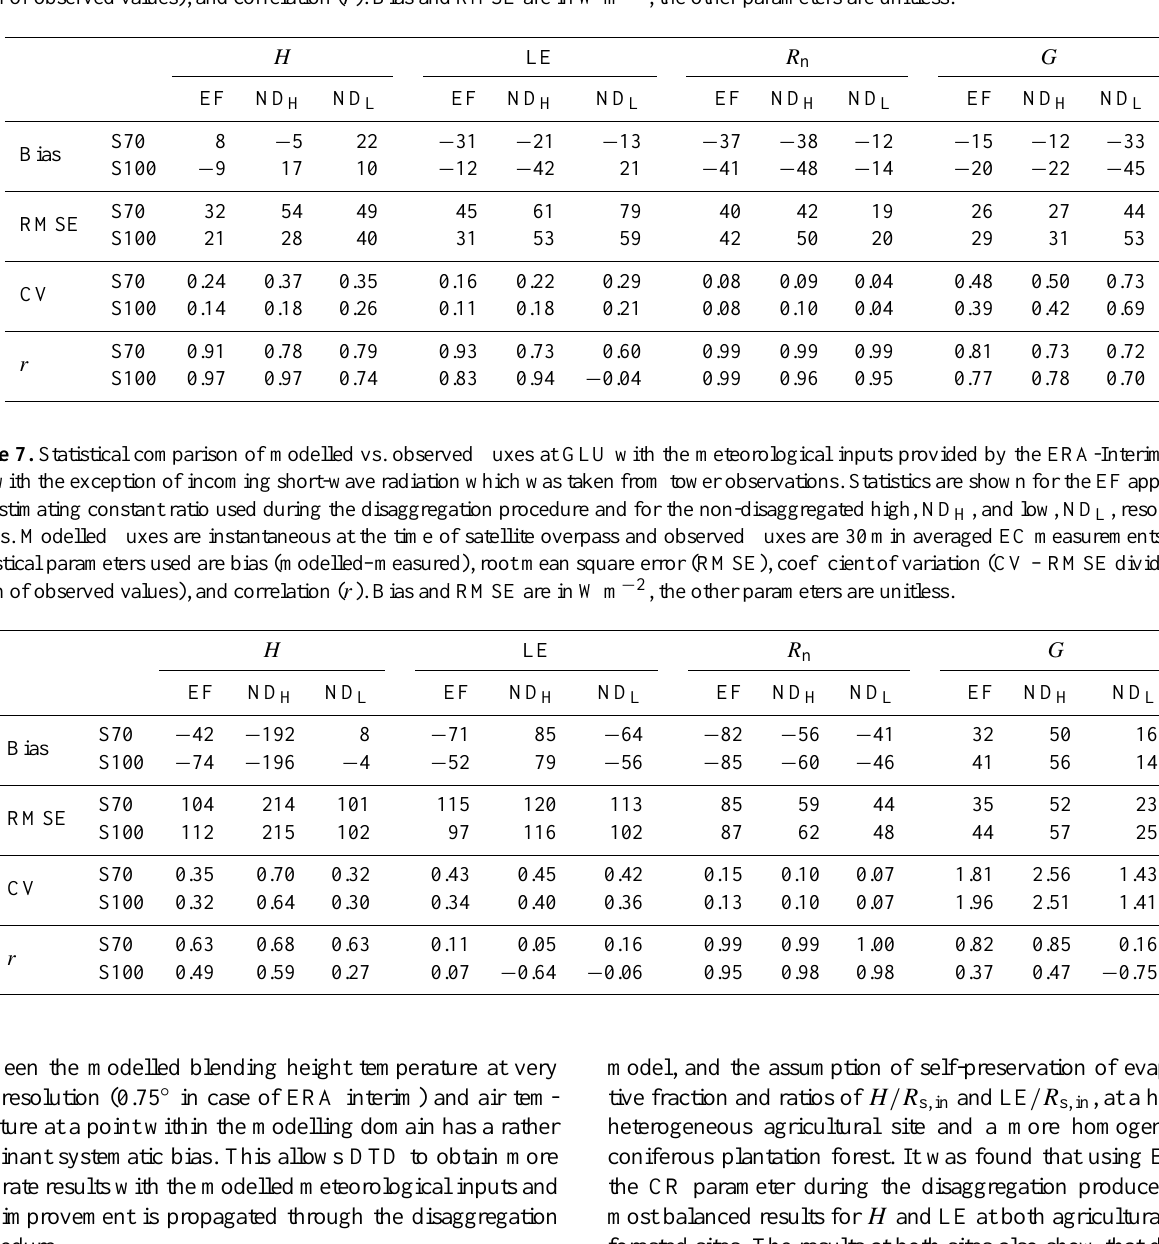
Table 6. Statistical comparison of modelled vs. observed fluxes at VOU with the meteorological inputs provided by the ERA-Interim data set, with the exception of incoming short-wave radiation which was taken from tower observations. Statistics are shown for the EF approach for estimating constant ratio used during the disaggregation procedure and for the non-disaggregated high, ND H , and low, ND L , resolution fluxes. Modelled fluxes are instantaneous at the time of satellite overpass and observed fluxes are 30min averaged EC measurements. The statistical parameters used are bias (modelled–measured), root mean square error (RMSE), coefficient of variation (CV – RMSE divided by mean of observed values), and correlation ( r ). Bias and RMSE are in Wm − 2 , the other parameters are unitless. H LE EF ND H